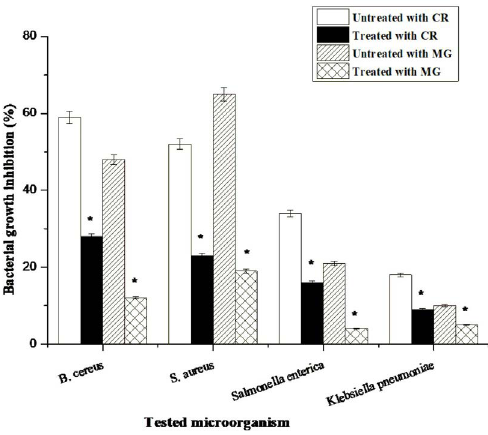
Fig. 5. Growth inhibition percentage of untreated and laccase-treated synthetic dyes (congo red (CR) and malachite green (MG)) against tested bacterial strains. Where, Untreated: dye solution without SSF laccase; Treated: dye solution treated with SSF laccase. The columns followed by asterisks are significantly different according to paired-samples t test. Values are the mean of three replicates. The bars represent the standard error of the mean.